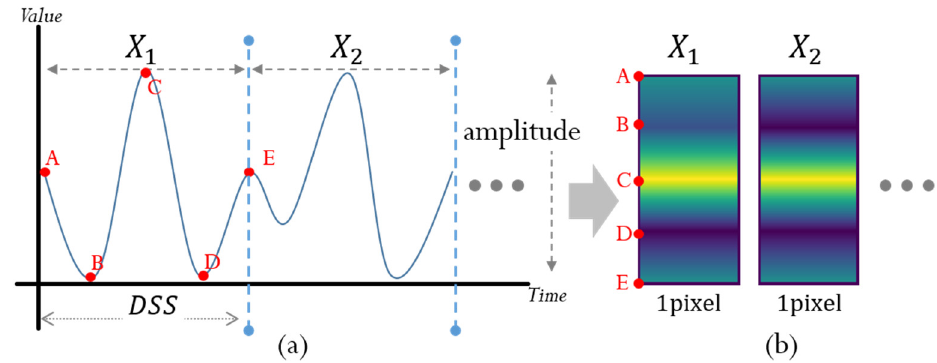
Figure 1. Brightness distribution transformation of raw sensor data: ( a ) raw data graph, and ( b ) brightness intensity distribution pattern ( BIDP ).